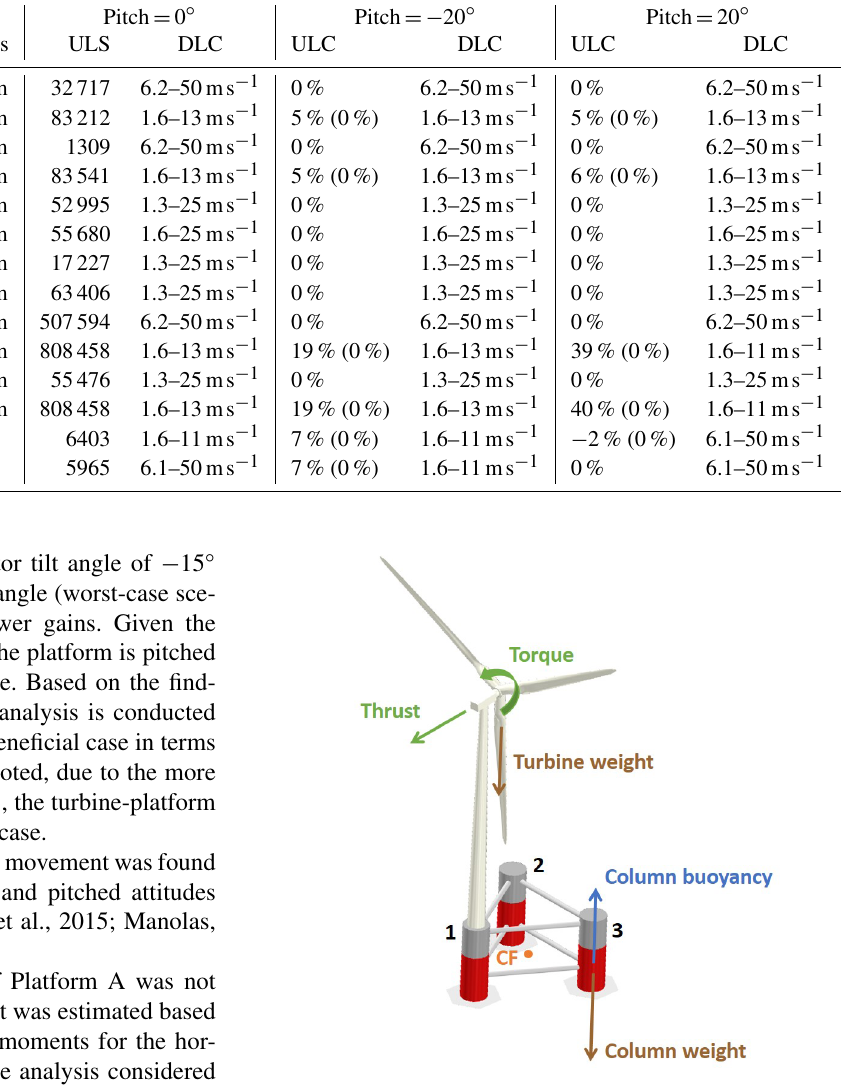
Figure 15. Forces and moments considered for the ballast calcula- tions. For clarity, only the forces on one of the columns are